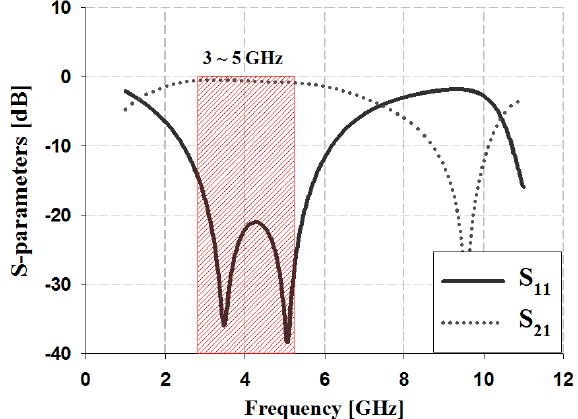
Figure 8. S-parameter simulation analysis of the proposed shifter.